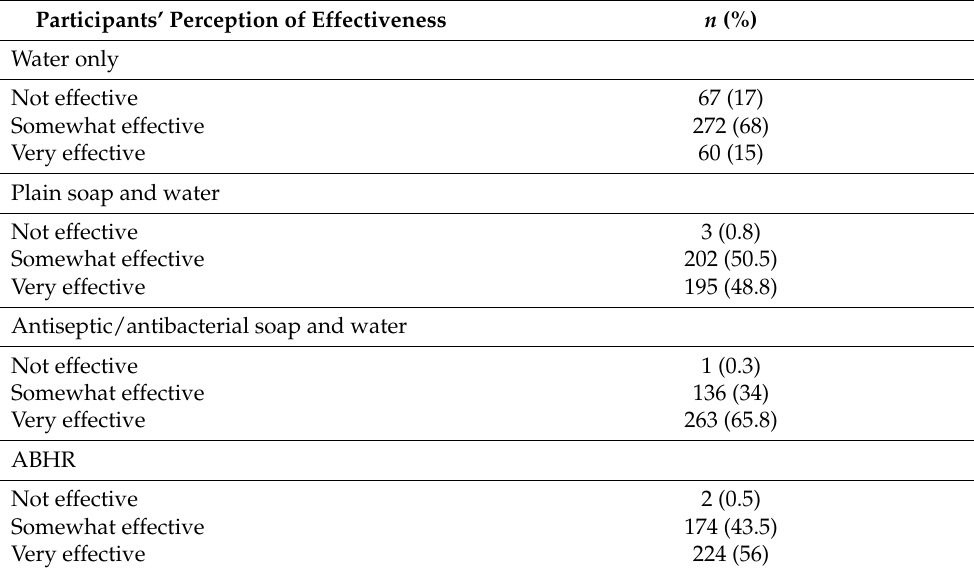
Table 3. Perceptions of the effectiveness of hand hygiene methods ( n =